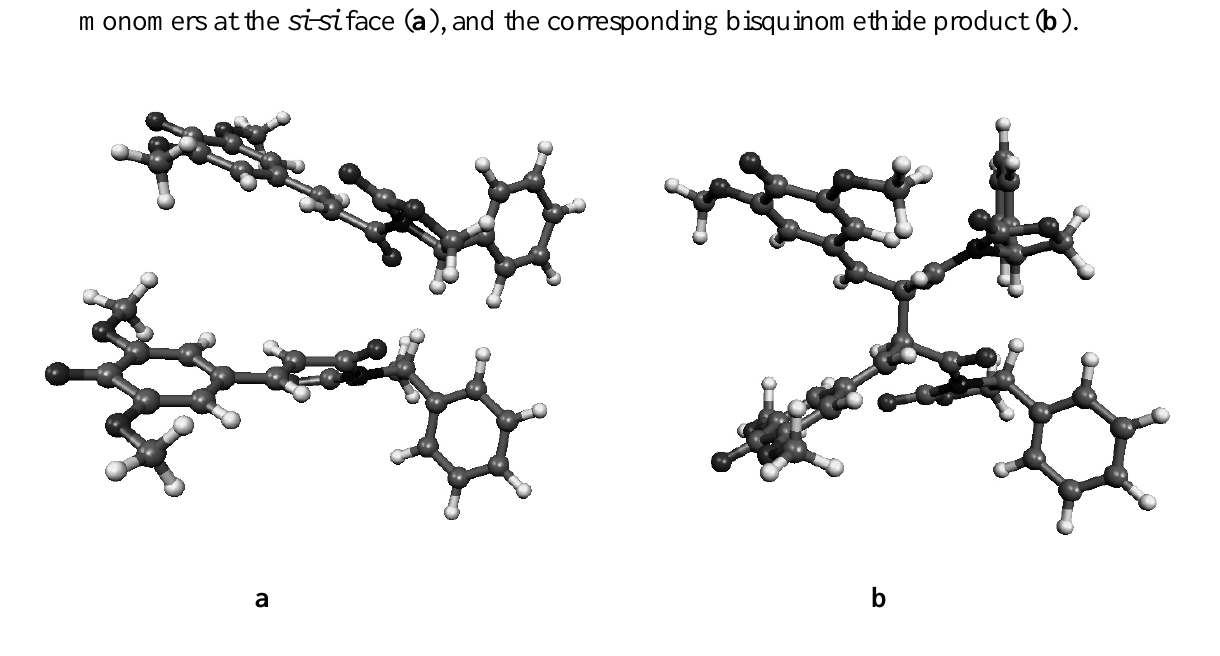
Figure 4c. Molecular geometry of the van der Waals pre-reactive complex with the monomers at the re - si face (a), and the corresponding bisquinomethide product (b).